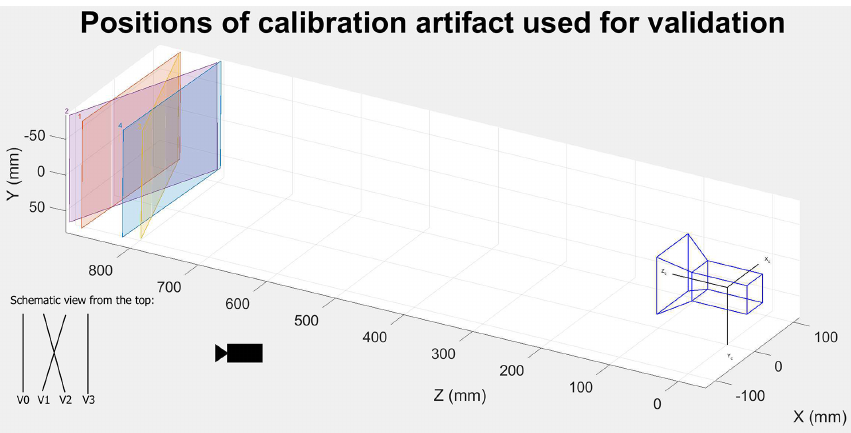
Figure 14. Positions of calibration artifact V0–V3 used for validation of the proposed thermal compensation